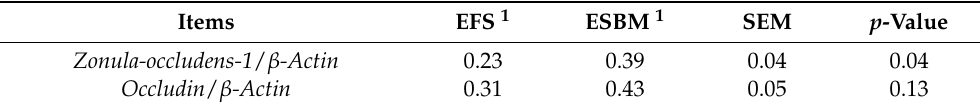
Table 7. Effects of enzyme-treated soybean meal replacing extruded full-fat soybean on protein expression of tight junction protein in jejunal mucosa in nursery pigs.